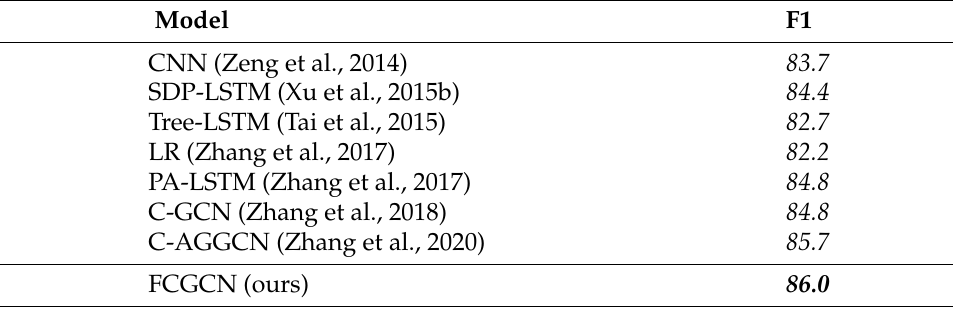
Table 3. Results on SemEval 2010 Task 8.